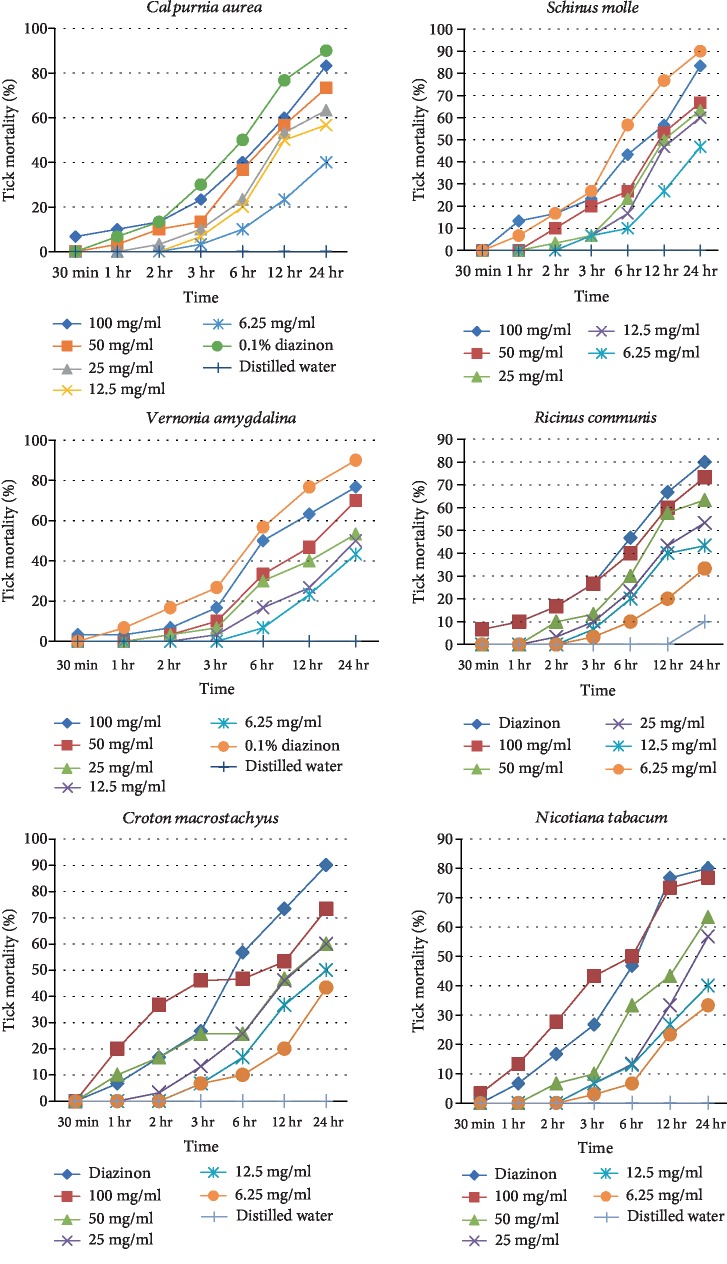
Mortalities of ticks treated with methanolic extracts of selected medicinal plants.